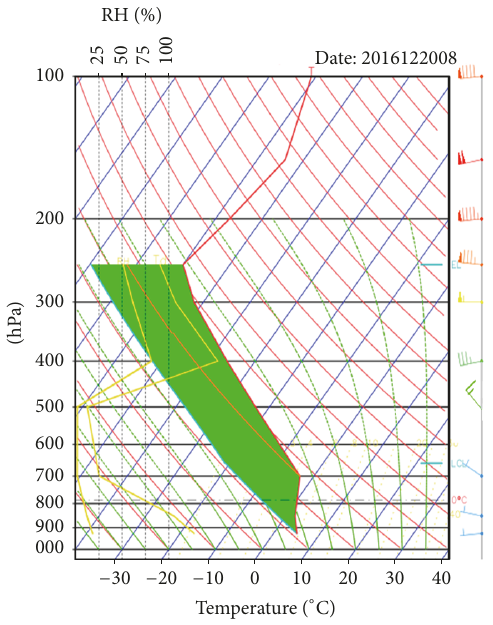
Figure 3: Vertical thermodynamic diagrams over Beijing on 20 December